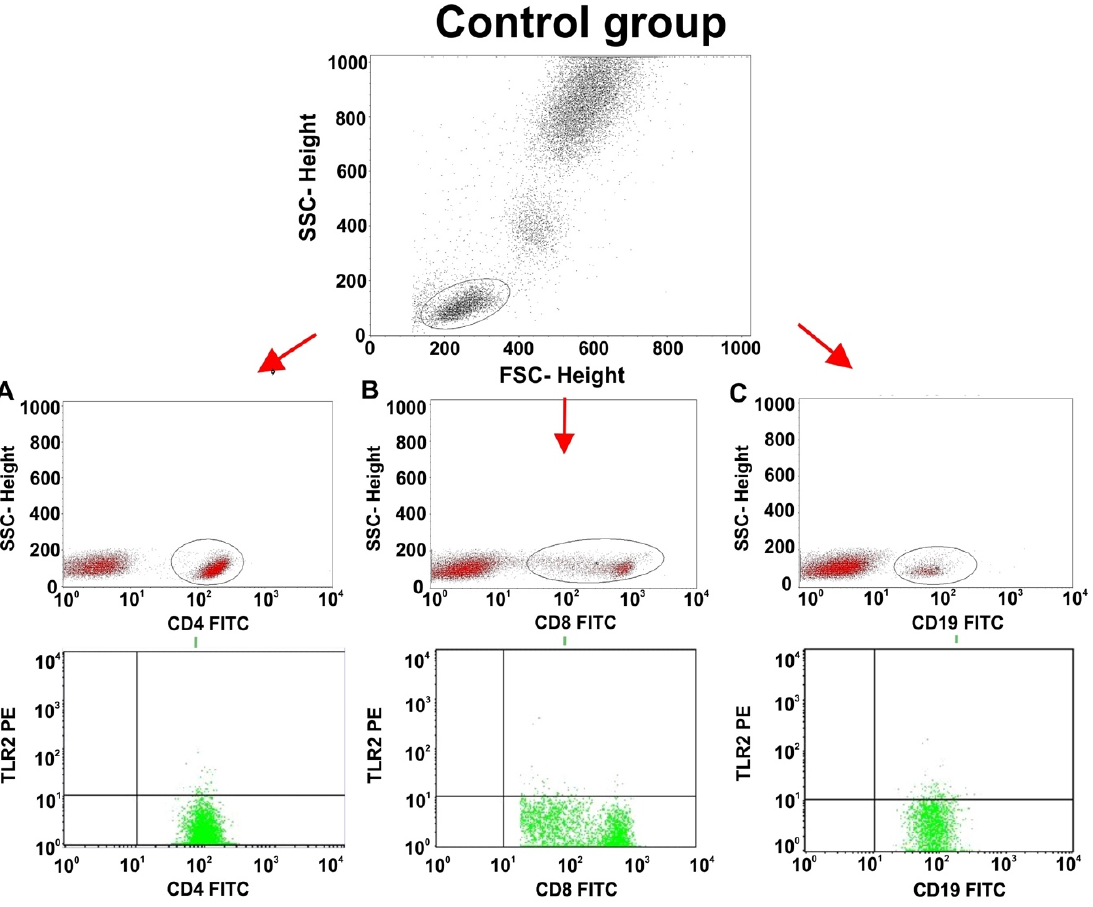
Figure A2. Sample analysis of CD4 +/ CD8 +/ TLR2 + on T lymphocytes and CD19 +/ TLR2 + on B lymphocytes in control patients ( A , B , C ).